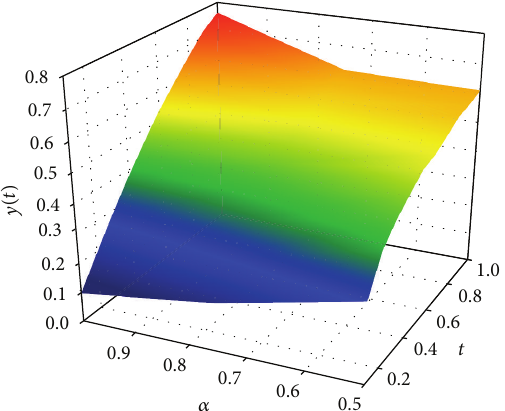
Figure 5: Numerical results of Example 3 by LWM for different values of 𝛼 .